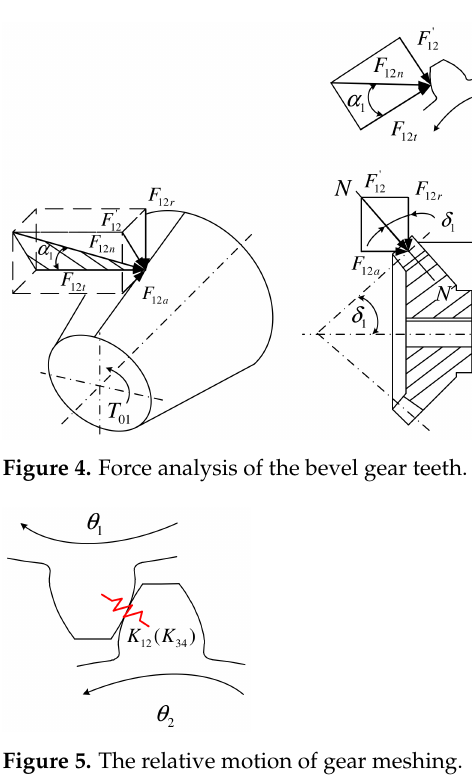
Figure 3. Bevel gear meshing transmission of the LSPR.